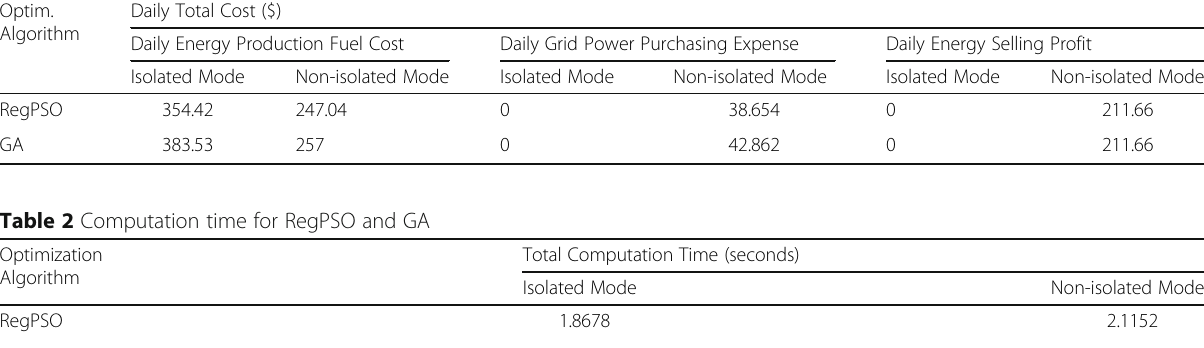
Table 1 Fuel and energy trading costs by RegPSO and GA Optim. Algorithm